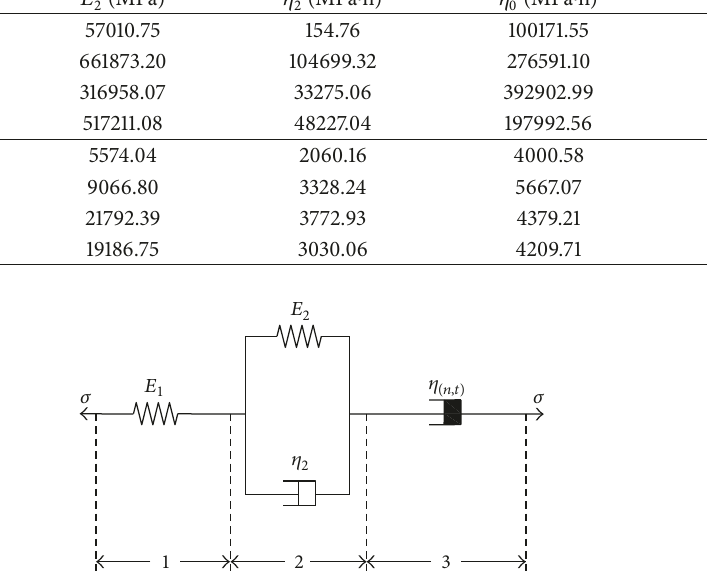
Figure 13: Illustration of the improved Burgers creep model.